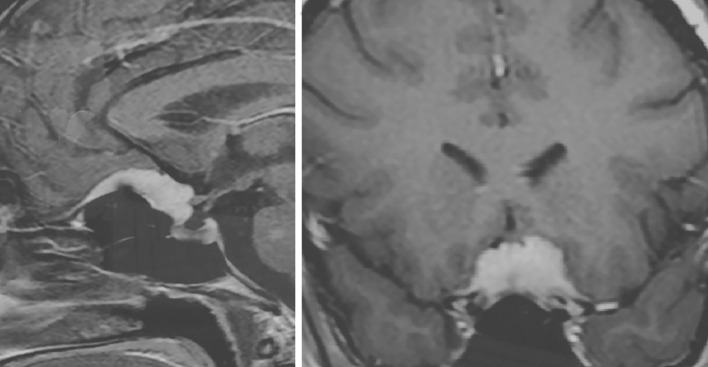
Post-contrast cranial MRI of 35-year-old female with tuberculum sellae meningioma presenting sudden onset of visual deficit during artificial in vitro fertilization treatment on the therapy with human chorionic gonadotrophin.